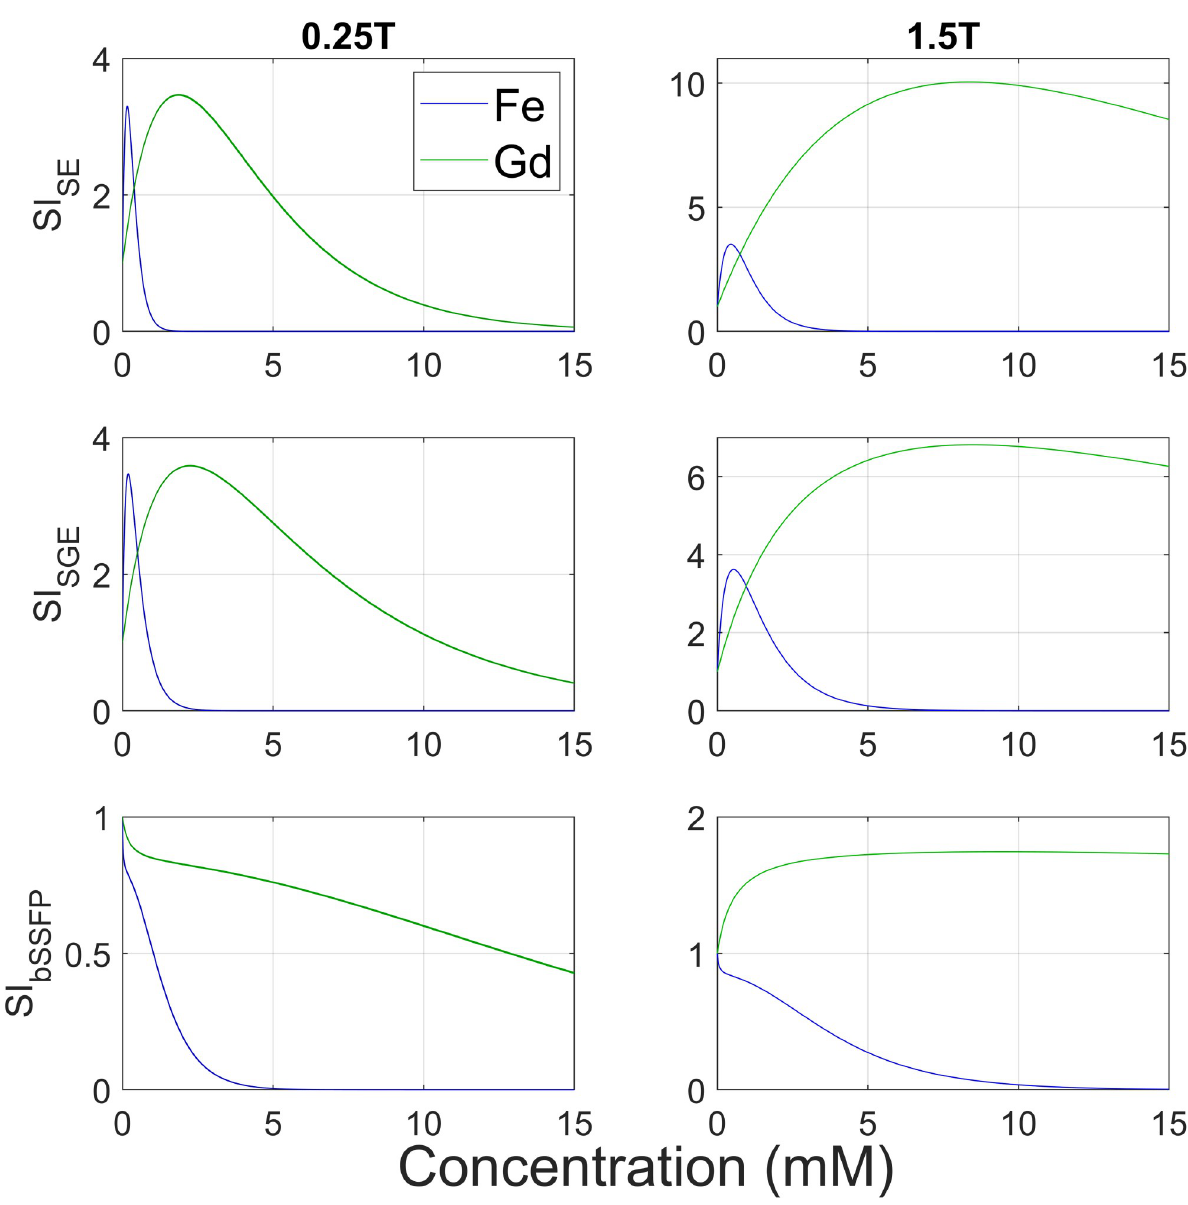
Fig 3. Simulated SIs calculated from 0–15 mM for ferumoxytol (Fe) and gadoterate (Gd) for an SE, SGE, and bSSFP sequence at 0.25T (left column) and 1.5T (right column). SIs are shown as normalized values as ratio to no CA (which corresponds with a value of 1). These simulations contributed to identifying relevant concentrations (0–0.15–0.30–1.20–7.0–14.0 mM) that were prepared to perform the experiments. Note the difference in y-axis between 0.25T and 1.5T and the lack of signal enhancement in the bSSFP sequence on 0.25T. relaxivities on 0.5T and 1.5T, these r of 259.5 mM -1 s -1 (ferumoxytol) and 21.6 mM -1 s -1 2 (gadoterate) were expected to be in the range of 80–120 mM -1 s -1 and 3–5 mM -1 s -1 respec- tively [6, 13].We hypothesize that this is due to signal loss in bSSFP; when this sequence is incorrectly balanced due to background gradients and a relatively long TR, the signal can � (instead of T become T ) dependent [36]. This results in a severe underestimation of T 2 2 ing to an overestimated r . Since the simulations were based on these overestimated r 2 simulated signal in the bSSFP sequence is lower than the measured signal. This was seen and